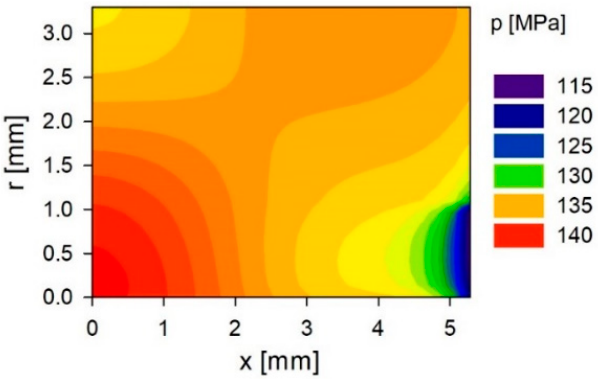
Figure 11. The pressure distribution inside the primer at 20 µ s.